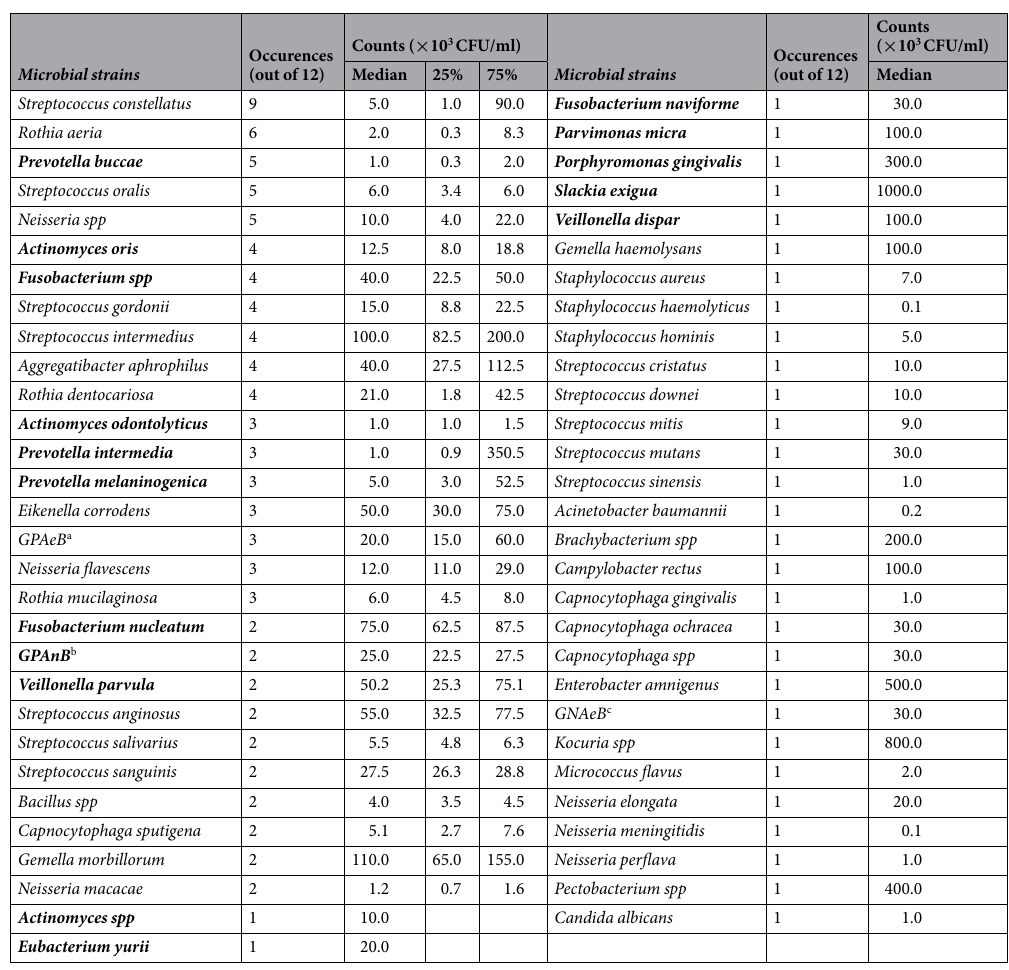
Table 1. Microbial strains detected from peri-implant pockets by MALDI-TOF MS, in a decreasing order of occurrences out of 12 samples. Microbial counts of each strains detected from different samples are presented in their median, 25% and 75% quartiles ( × 10 3 CFU/ml). The boldfaced strains are anaerobic. a GPAeB :